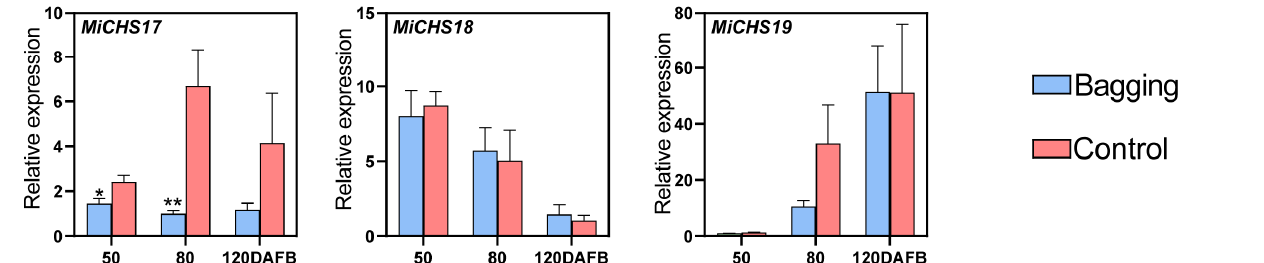
Figure 6. Expression profiles of MiCHS genes during the bagging treatment. Bagged (blue bars) and control (red bars) ‘Sensation’ mango peels were collected at 50, 80 and 120 DAFB. The data represent the mean value ± SD, n = 3. * indicates a significant difference ( p -value < 0.05). ** indicates a very significant difference ( p -value < 0.01), as determined by Student’s t -test.